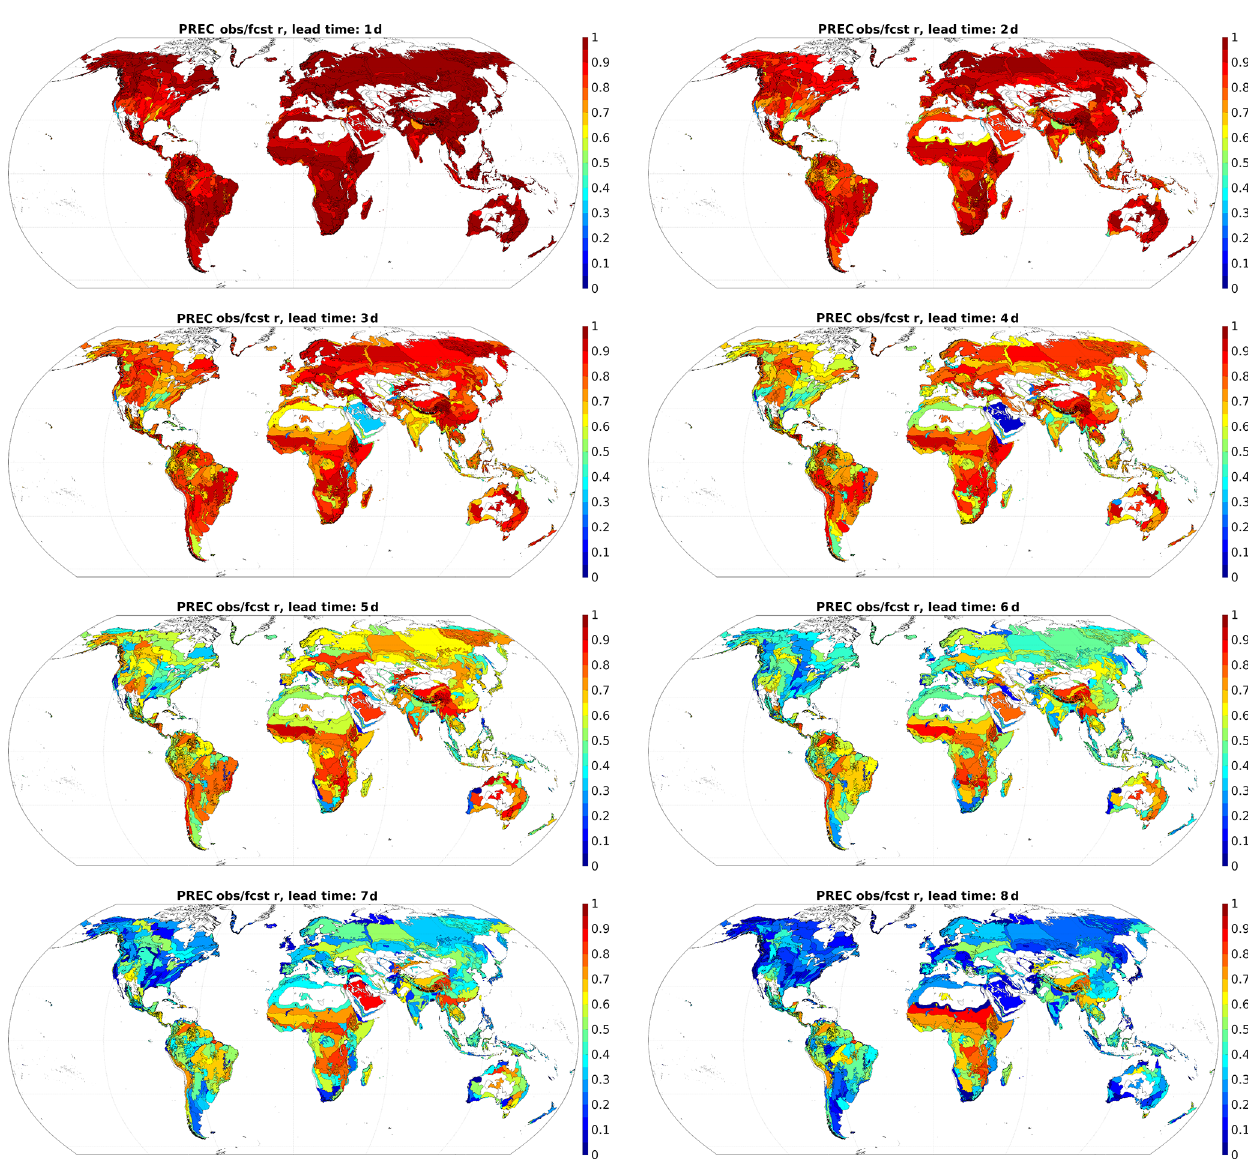
Figure 15. Same as Fig. 11 but for precipitation